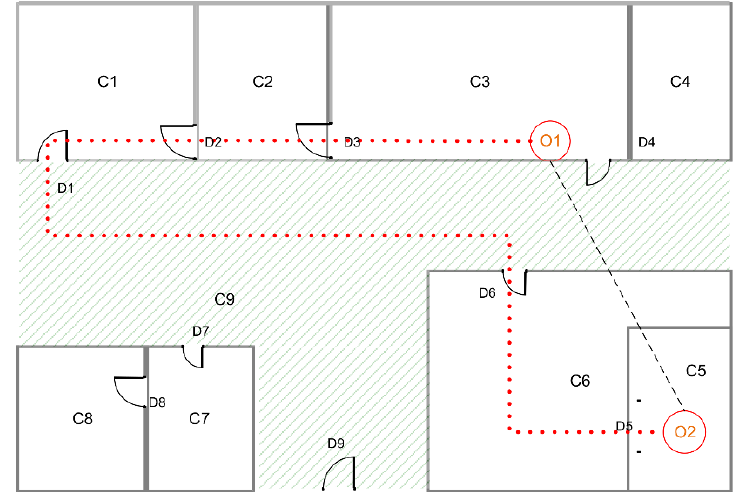
Figure 1. Euclidean distance and real distance.